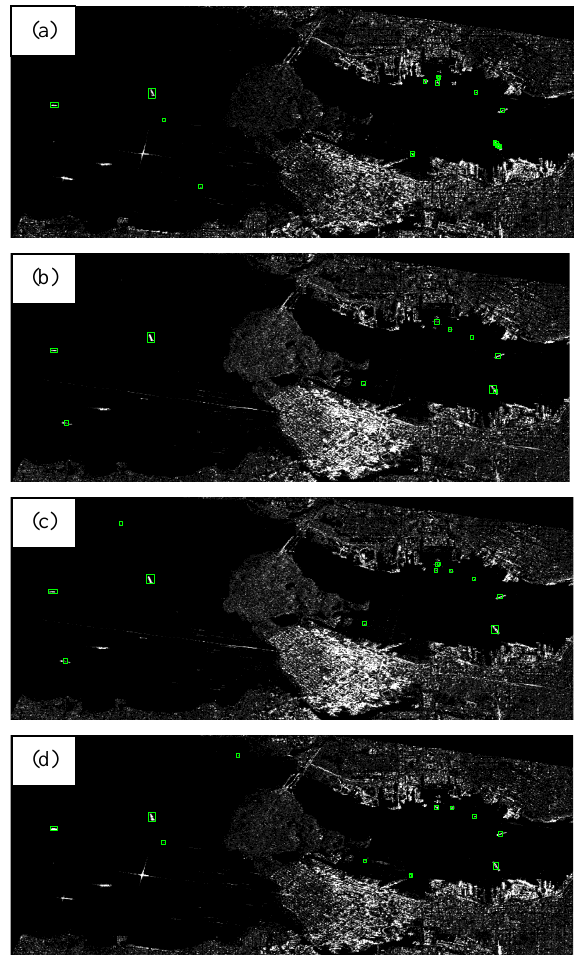
Figure 4. Detected ship targets in (a) HH, (b) HV, (c) VH and (d) VV polarizations, for the RadarSat-2 scenes, using a CFAR stencil of size 7751 x .